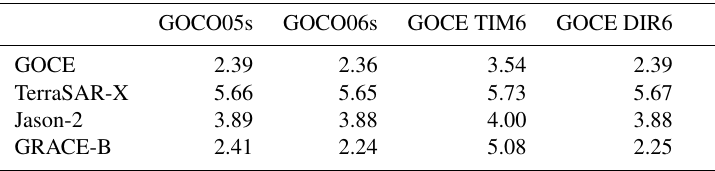
Table 4. Root mean square of differences between integrated dynamic and GPS-derived kinematic orbits in centimeters for four selected months during the GOCE measurement time span for satellites of different altitude and inclination.